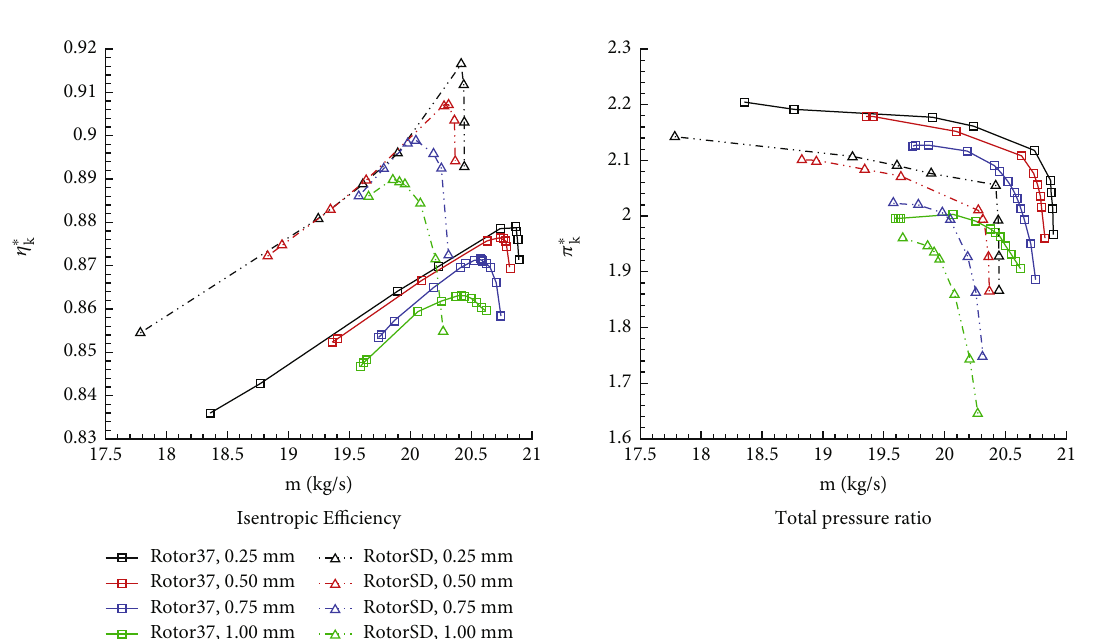
Figure 7: Performance of NASA Rotor37.